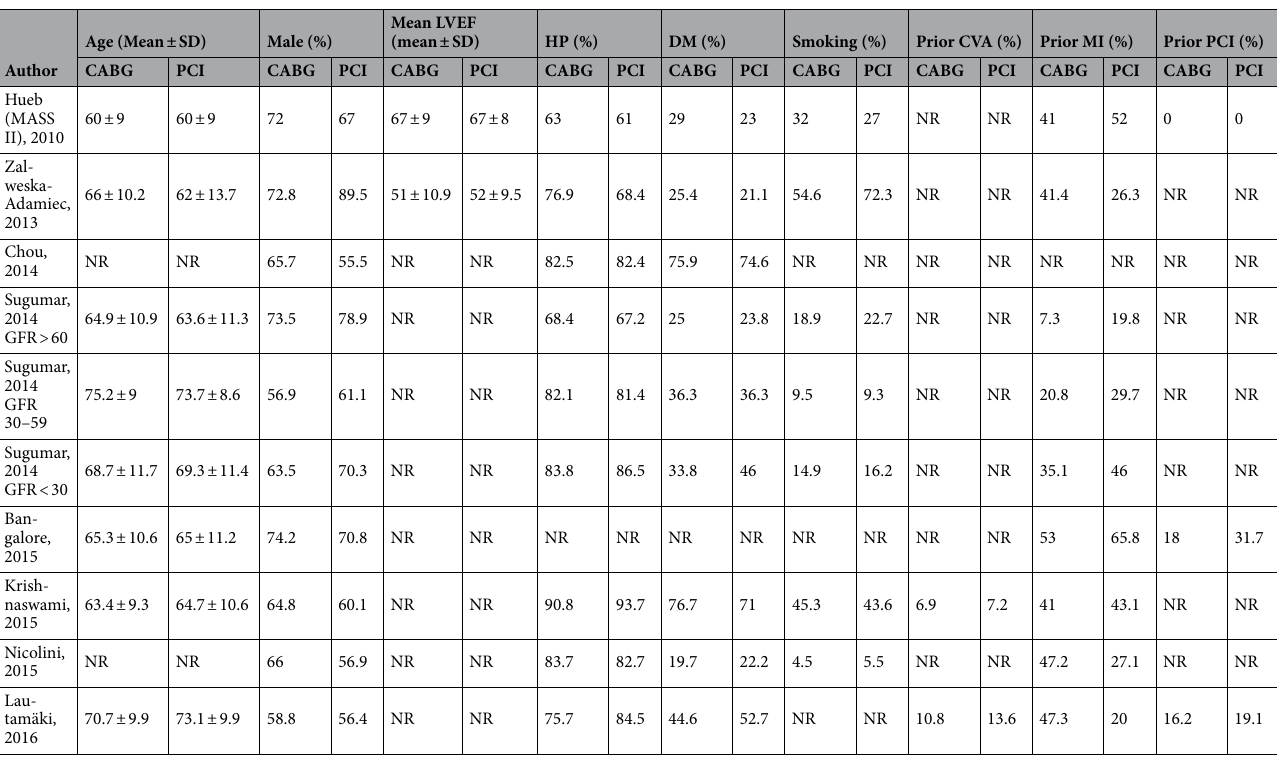
Table 2. Demographic data from the included studies (part 1). CABG coronary arterial bypass graft, CVA cerebrovascular accident, DM diabetes, GFR glomerular filtration rate, HP hypertension, LVEF left ventricular ejection fraction, MI myocardial infarction, NR not reported, PCI percutaneous coronary intervention, SD standard deviation.